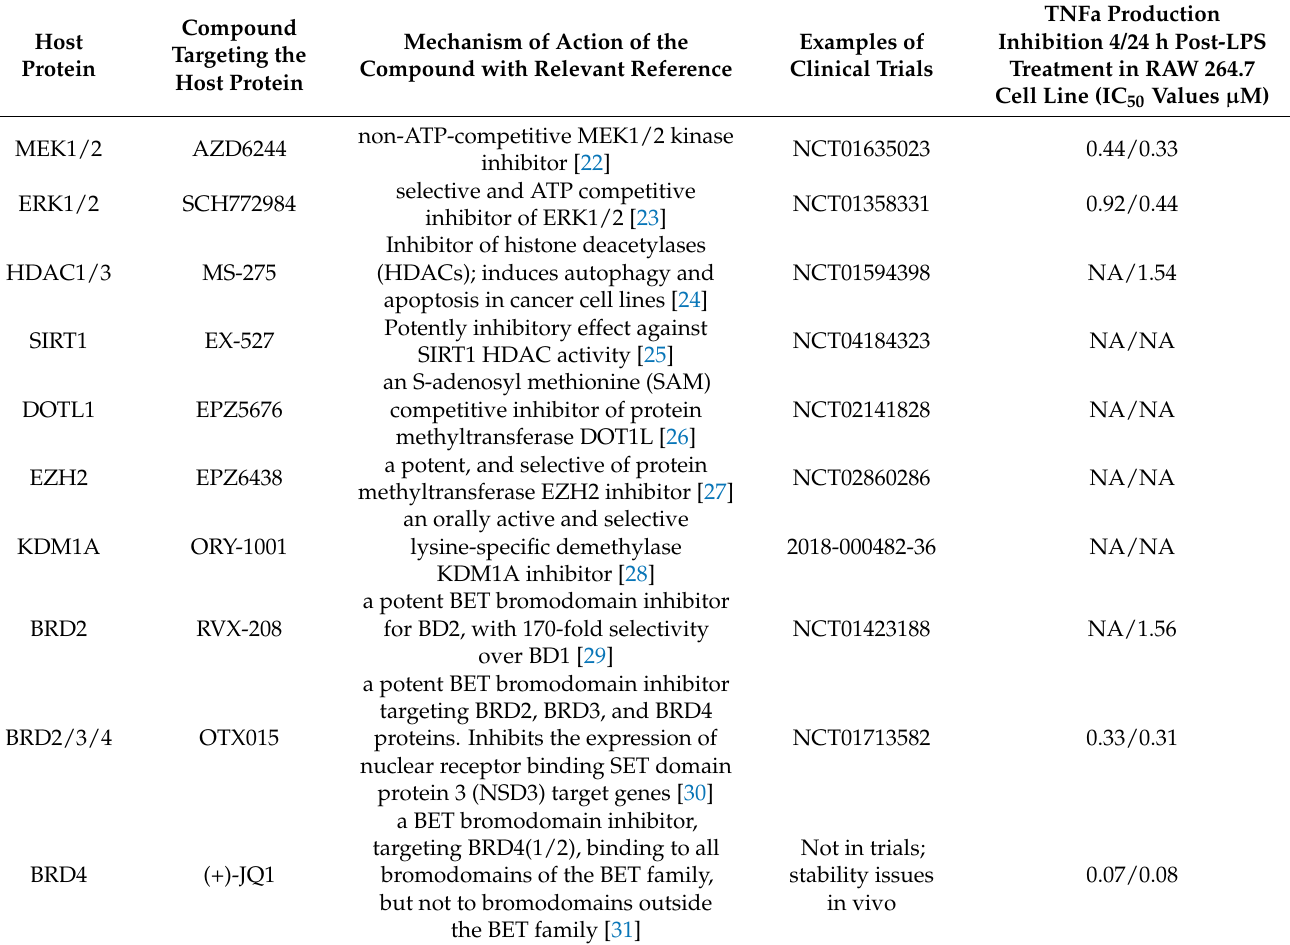
Table 1. List of small molecules together with representative IDs of clinical trials and used in in vitro